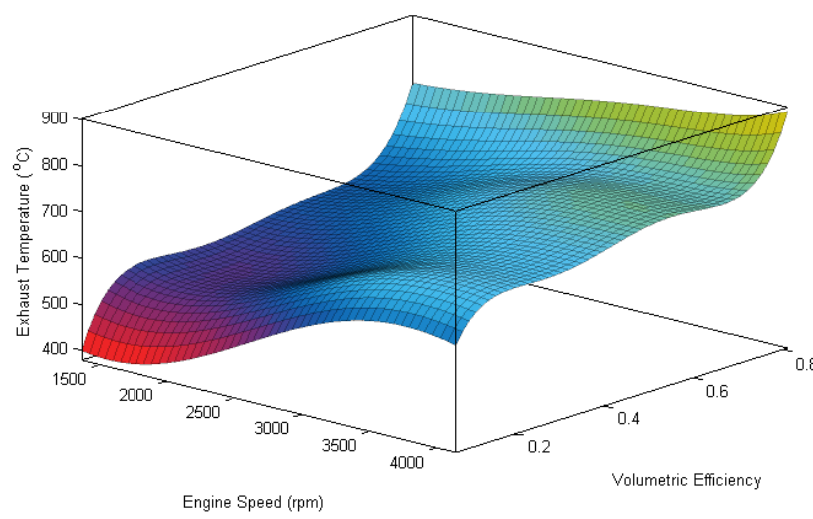
Figure 3. Map of the exhaust temperature vs. engine speed and volumetric efficiency. Energies 2017 , 10 , 1948